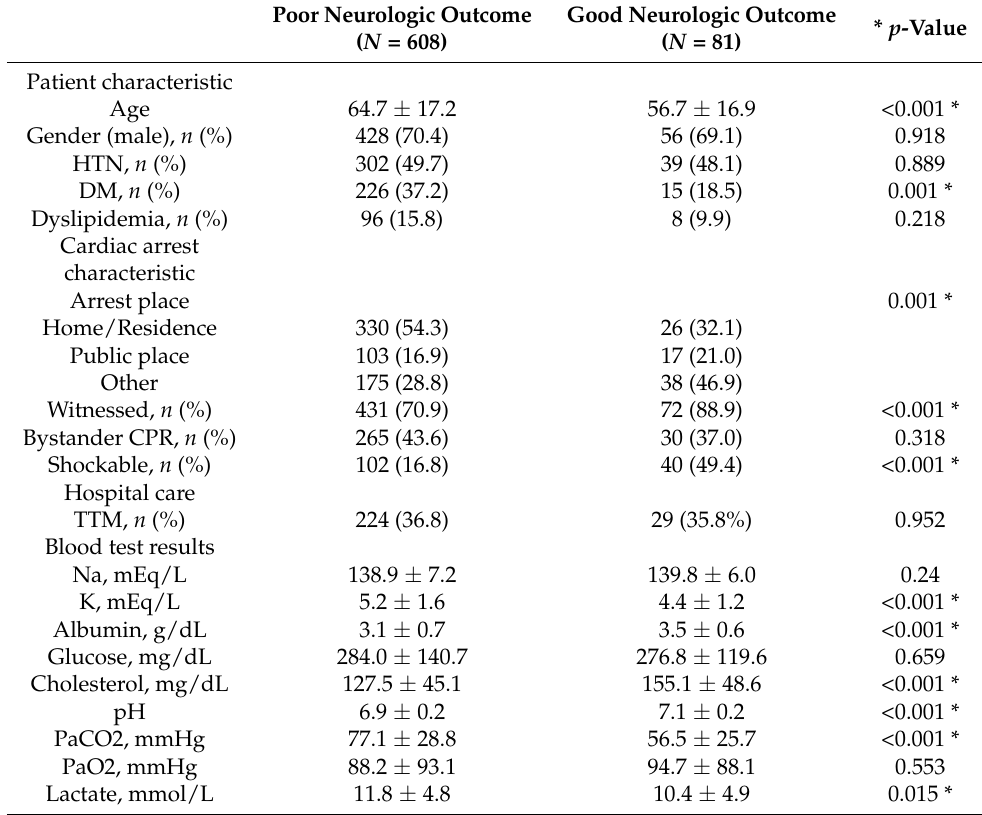
Table 1. Baseline characteristics of out-of-hospital cardiac arrest patients with neurologic